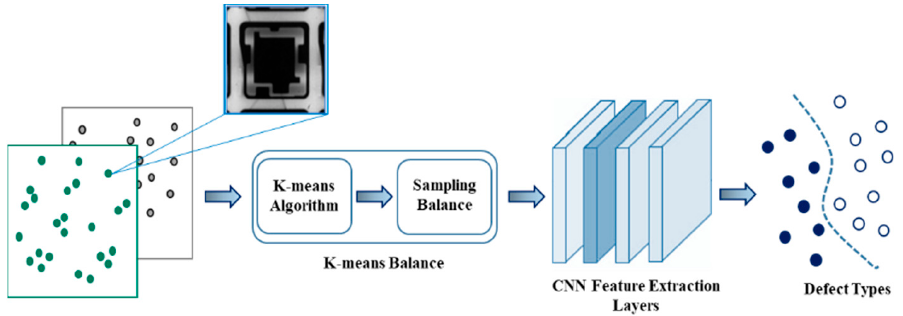
Figure 3. Framework of the proposed method.